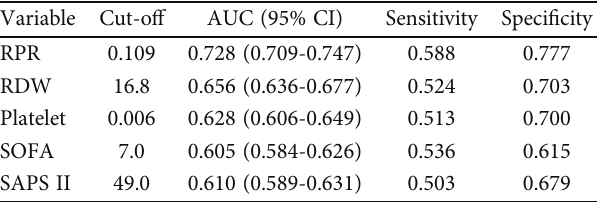
organ failure assessment; SAPS II: simpli fi ed acute physiology score